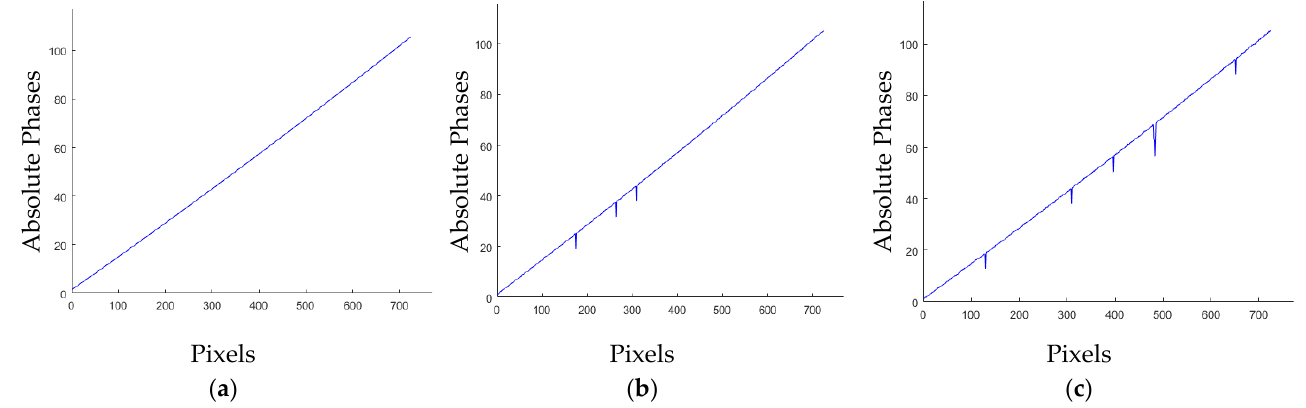
Figure 3. Phase unwrapping by the method in literature [15] under different noises. Phase expansion by the method of [15] when no Gaussian noise is added ( a ). The phase expansion is performed by the method of [15] when adding the first set of Gaussian noise ( b ). The phase expansion is performed by the method of [15] when adding the second set of Gaussian noise ( c ). As shown in Table 1, compared with the traditional method, the correction rate of absolute phase jumping points can reach more than 96.8%, and in the face of Gaussian noise with different mean values and variances, only a few jumping points are not corrected. by the method in this paper is also